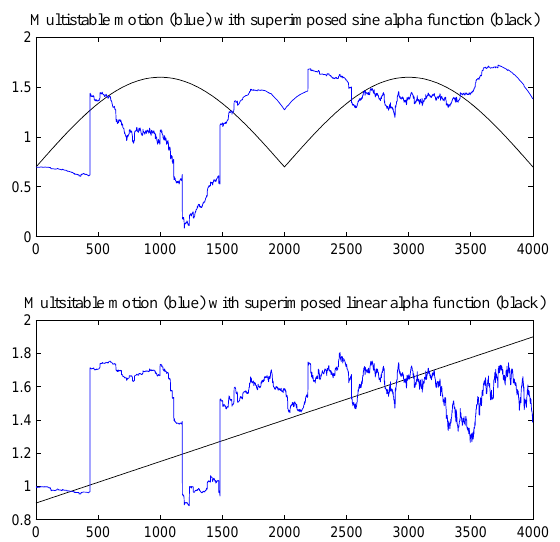
Fig. 15. Two multistable motions (blue curves) with sine(top, black Fig. 16. Two multistable motions (blue curves) with sine(top, black curve) and linear (bottom, black curve) local jump intensity func- curve) and linear (bottom, black curve) local jump intensity func- Fig. 16. Two multistable motions (blue curves) with sine(top, black tion. Larger jumps occur when the local jump intensity function is tion. Larger jumps occur when the local jump intensity function is small. curve) and linear (bottom, black curve) local jump intensity func- small. tion. Larger jumps occur when the local jump intensity function is small.